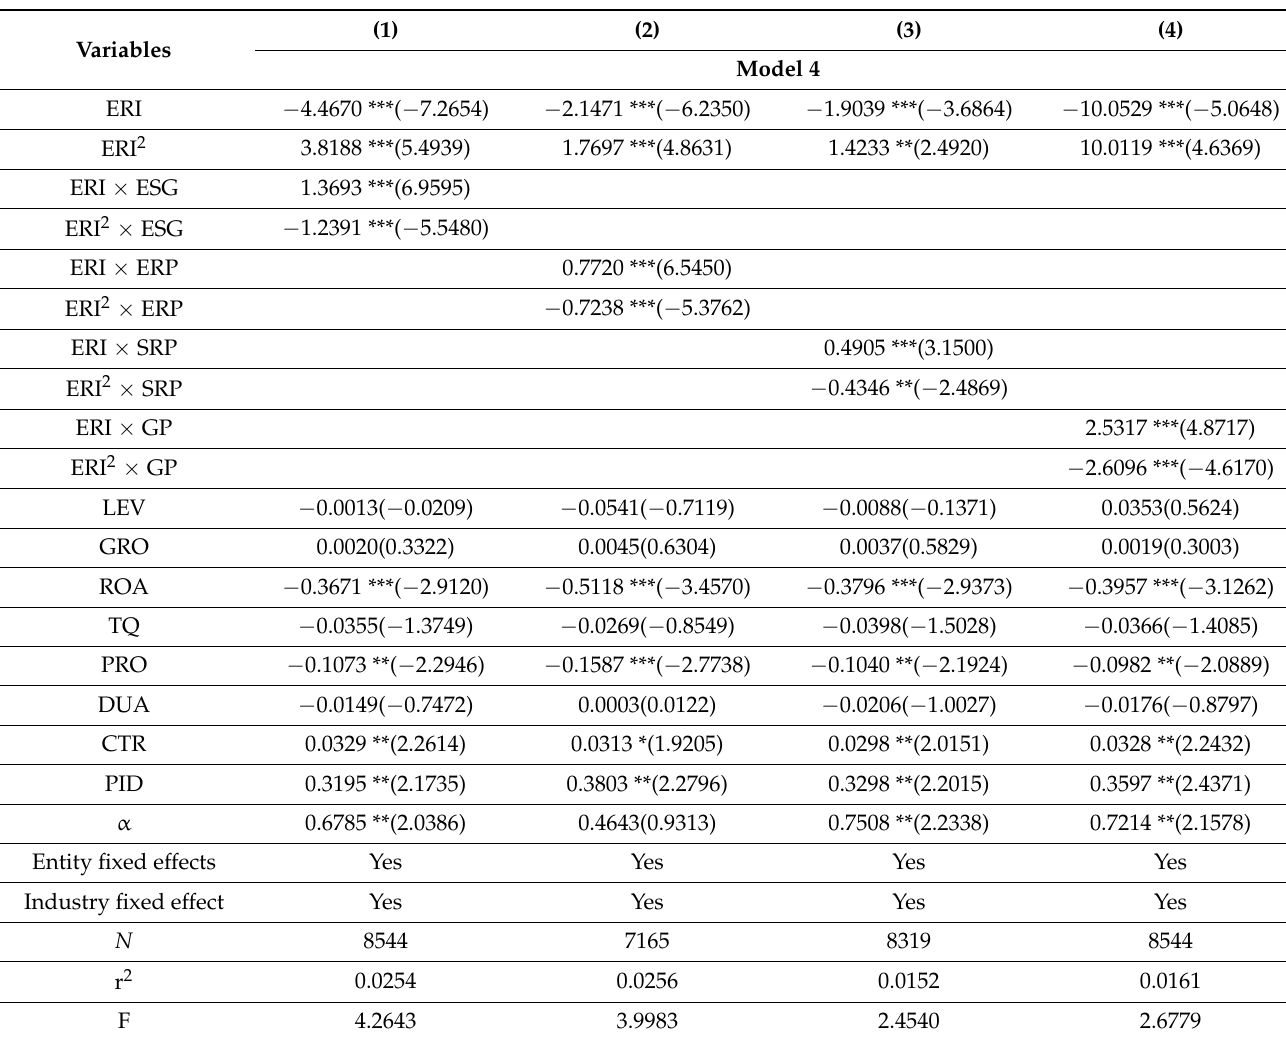
Table 5. Empirical results of regulatory effect of